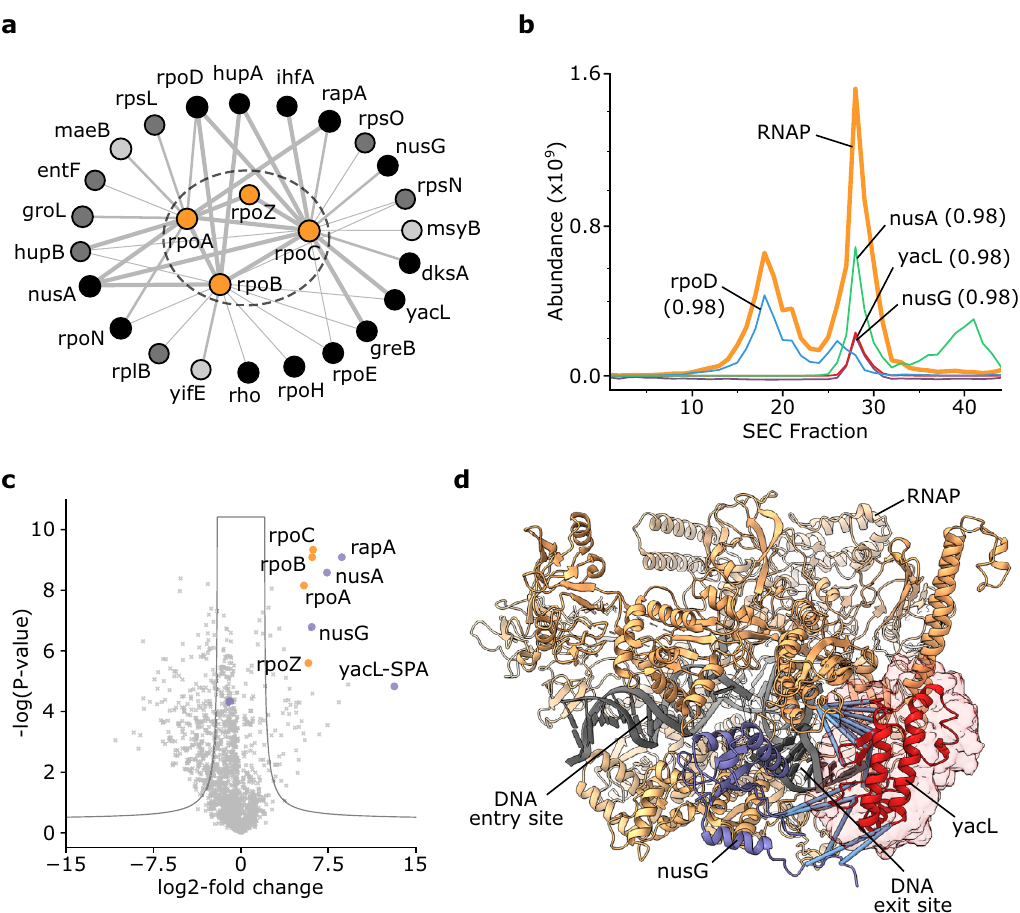
Fig. 4 The uncharacterised protein YacL binds to RNA polymerase. a PPI subnetwork of RNAP. Line thickness between proteins (circles) increases with frequency of observed crosslinks (i.e. one, two, three and more crosslinked residue pairs). Colour scheme for RNAP binders: light grey = coelution correlation > 0.5, dark grey = STRING database combined score ≥ 150, black = both of the previous categories. b Elution traces of RNAP (average abundance of its subunits) and selected RNAP binders with their minimal elution correlation coef fi cient to any RNAP constituent. c Volcano plot showing the af fi nity enrichment of SPA-tagged YacL, which co-enriches RNAP (orange) and a number of proteins found crosslinked to the RNAP in the YacL af fi nity-enrichment experiment (violet). d RNAP with bound NusG (PDB 6C6U [10.2210/pdb6c6u/pdb]) and the region of Crosslinking MS-de fi ned accessible interaction space with 14 satis fi ed restraints for YacL (I-TASSER model, placed for visualisation purposes) highlighted. Crosslinks between YacL and NusG or RNAP are highlighted in